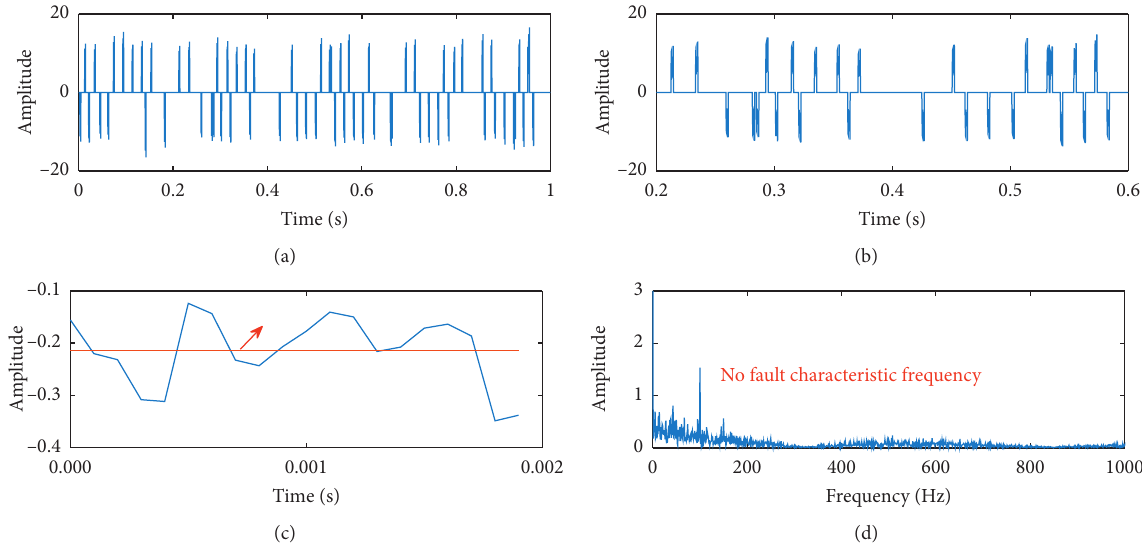
Figure 30: UC-DLA with parameters n � 20 ,k � 13 , L � 1 for identification of wheelset bearing roller fault. (a) Sparse reconstruction signal; (b) locally zoomed figure of the impulses shown in Figure 30(a); (c) learned shock responses; and (d) envelope spectrum of signal in Figure